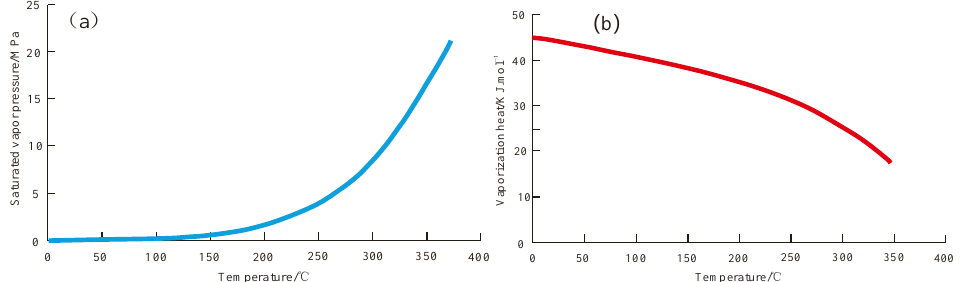
Figure 19. Variation in saturated vapor pressure and evaporation heat with temperature: ( a ) Saturated vapor pressure; ( b ) Vaporization heat.